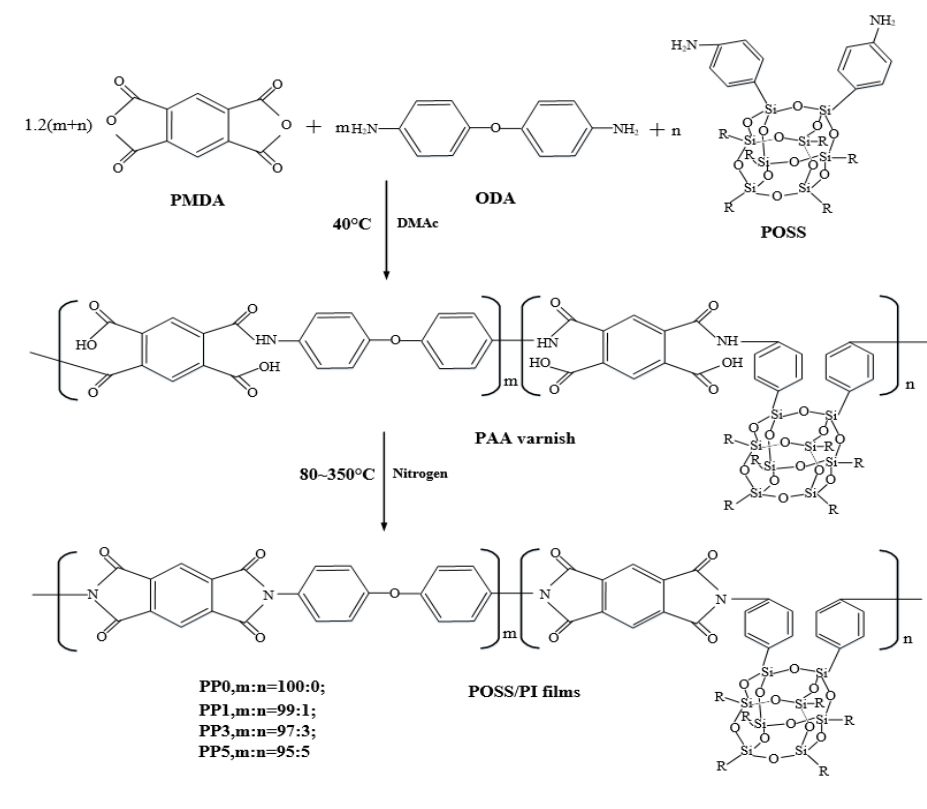
Polymers 2022 , 14 , x FOR PEER REVIEW Figure 1. Synthesis route of POSS/PI composite film. Figure 1. Synthesis route of POSS/PI composite film. Table 1. Modification scheme.